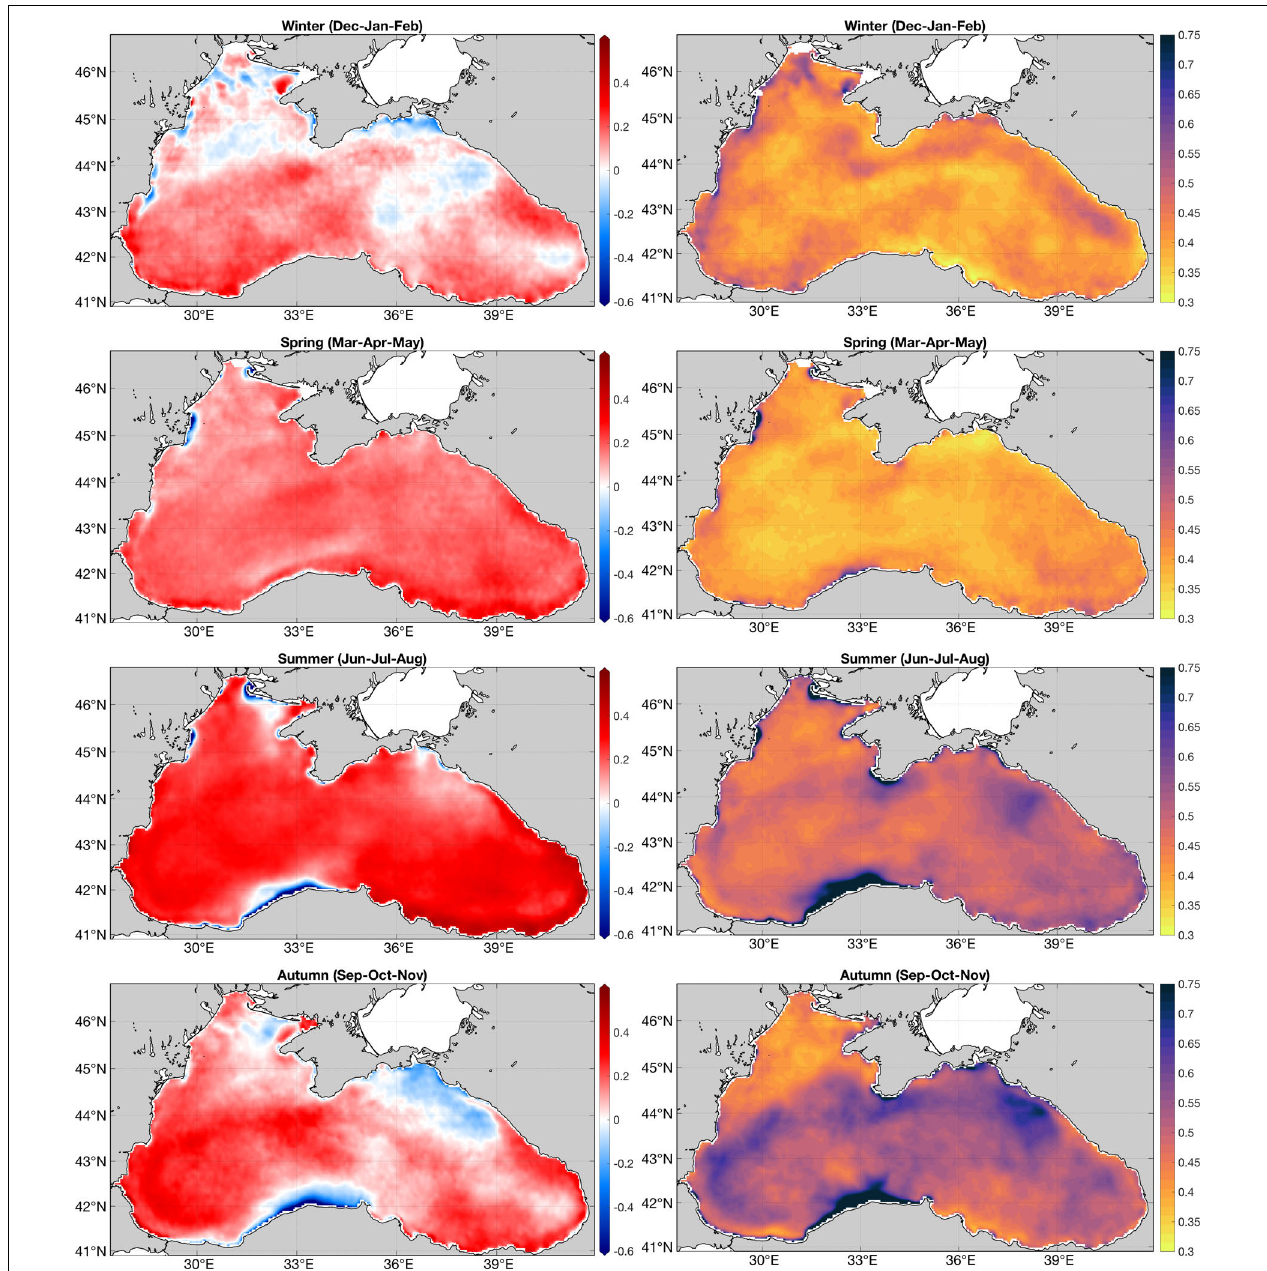
FIGURE 2 | Seasonal maps of the mean bias (left) and RMSD (right) of the SST ( o C) with respect to the satellite SST-L4 products over the period between 1993 and 2018. From top to bottom: winter, spring, summer, and autumn.